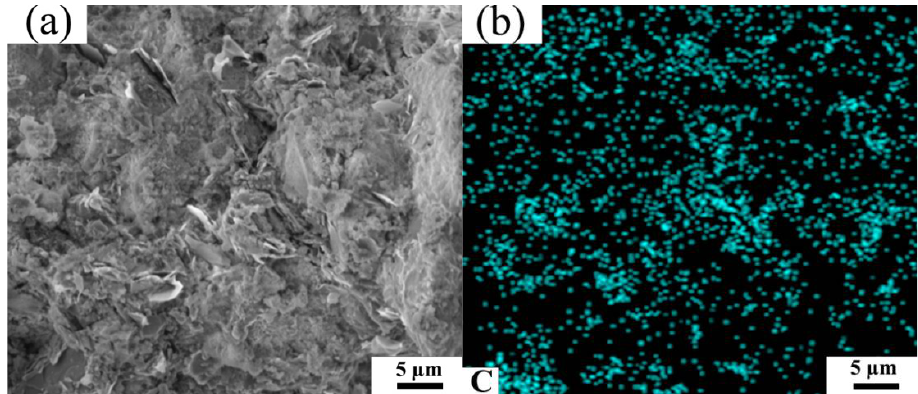
Figure 7. ( a ) SEM image and ( b ) C elemental mapping of graphite–cement mortar with standard sand as an aggregate.